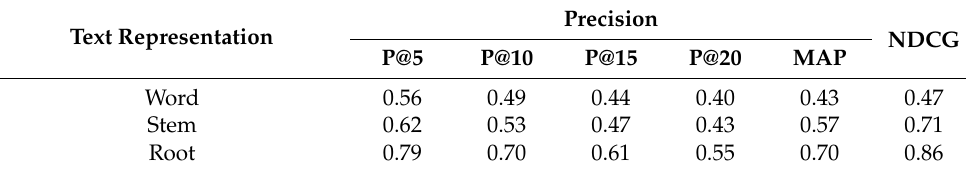
Table 9. Word-based, stem-based, root-based retrieval.